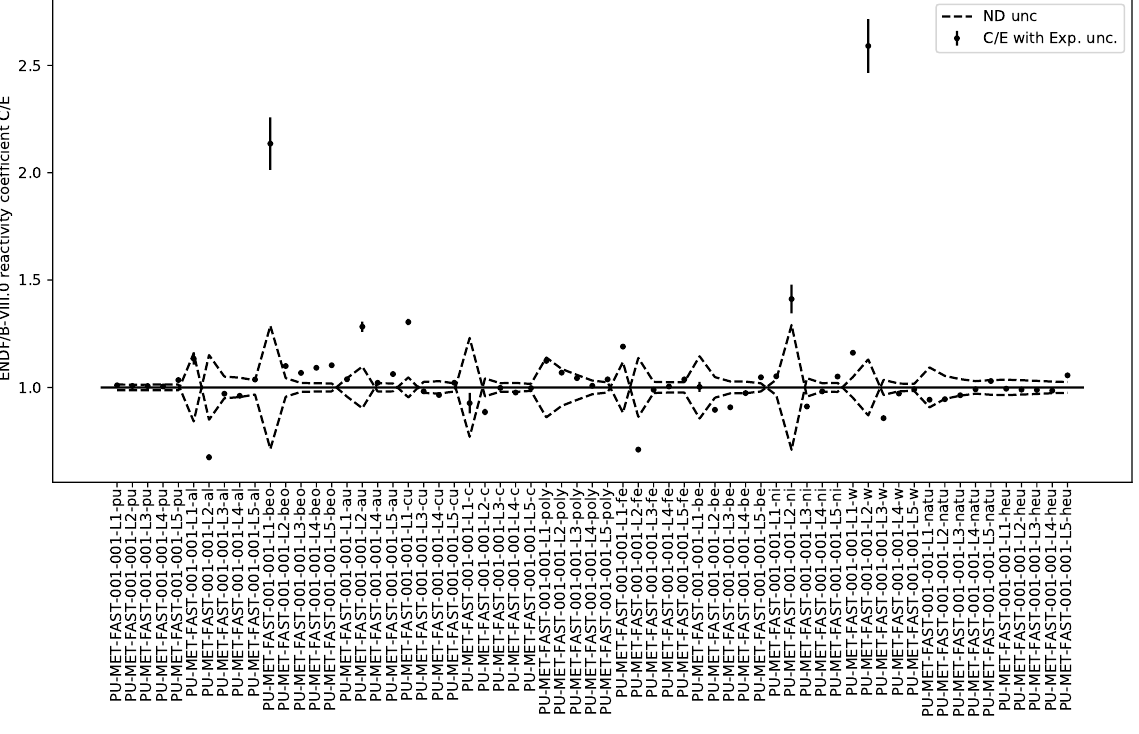
Figure 4. The same as Fig. 1 except for the reactivity coe ffi cients in the PU-MET-FAST-001 (Jezebel) critical assembly. “Lx” specifies the location of the